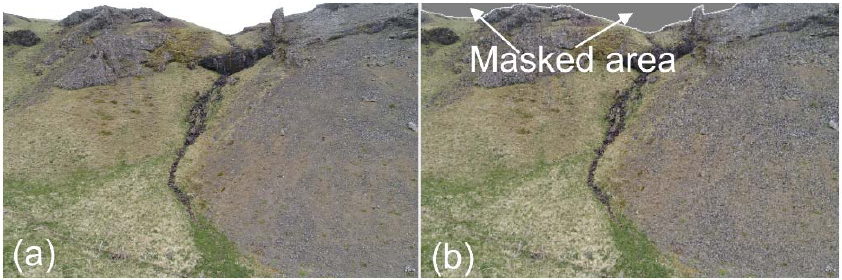
Figure 4. Example of UAV ‐ collected picture with nadir camera orientation ( a ), and where a mask to exclude the sky from processing has been applied ( b ).